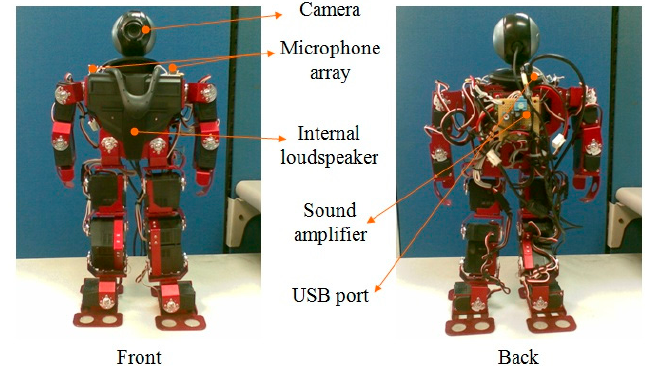
Figure 3. Humanoid robot 16-DOF Robotinno TM .